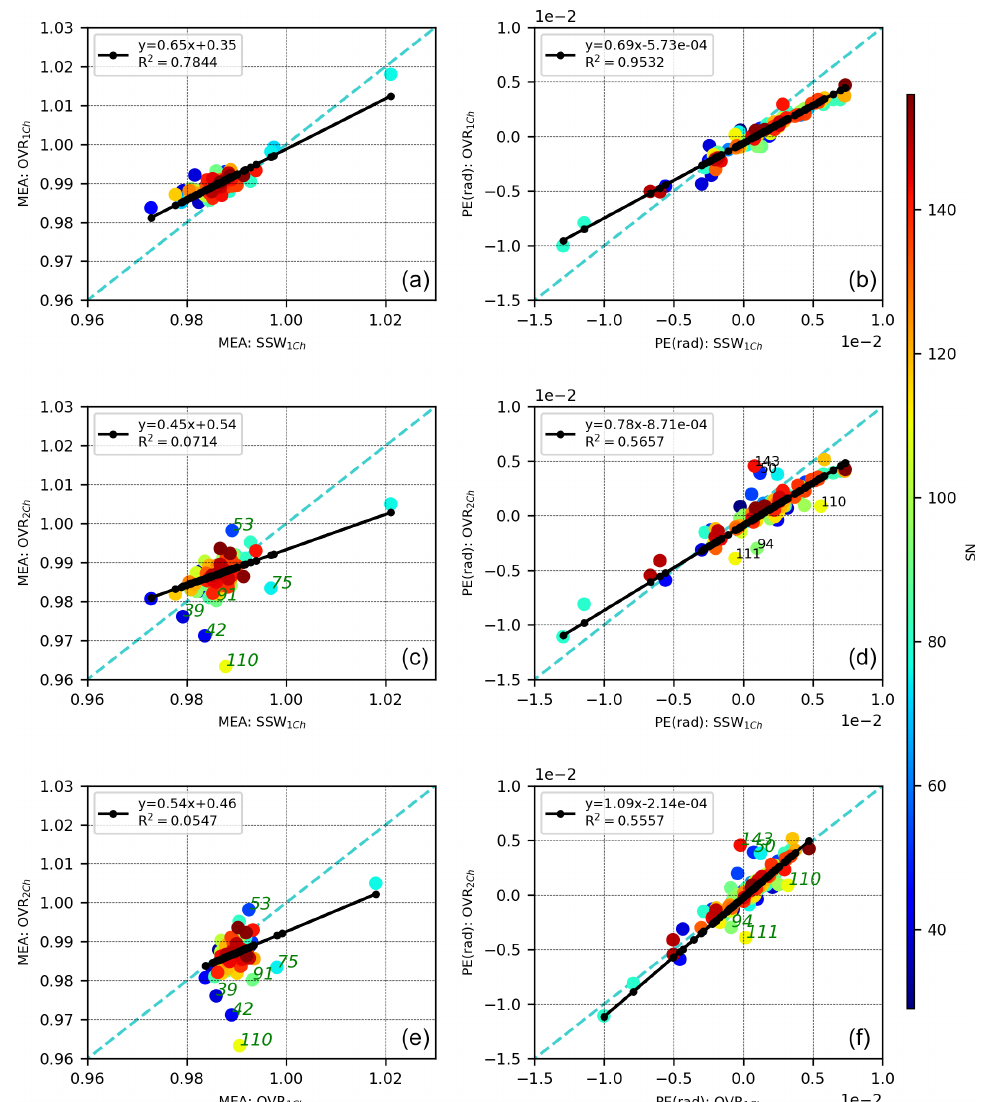
Figure 11. Correlation plots between the MEAs (a, c, e) and PEs (b, d, f) . (a, b) The first channel in the SSW and in the OVR region, (c, d) the first channel in the SSW and the second channel in the OVR region, and (e, f) the first channel in the OVR and the second channel in the OVR region. Additionally, the obvious outliers are labelled in order to assess